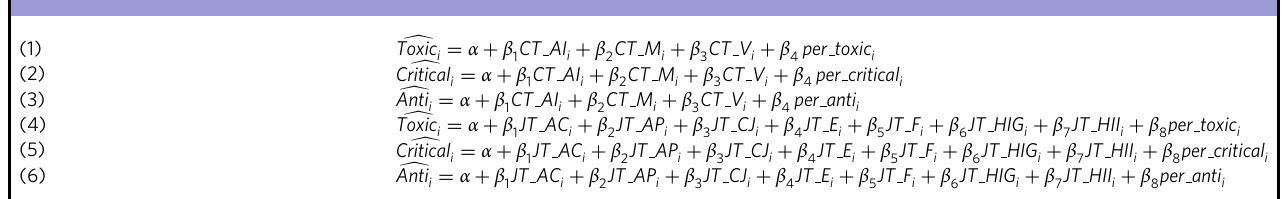
Table 3 Summary of the logistic regression models